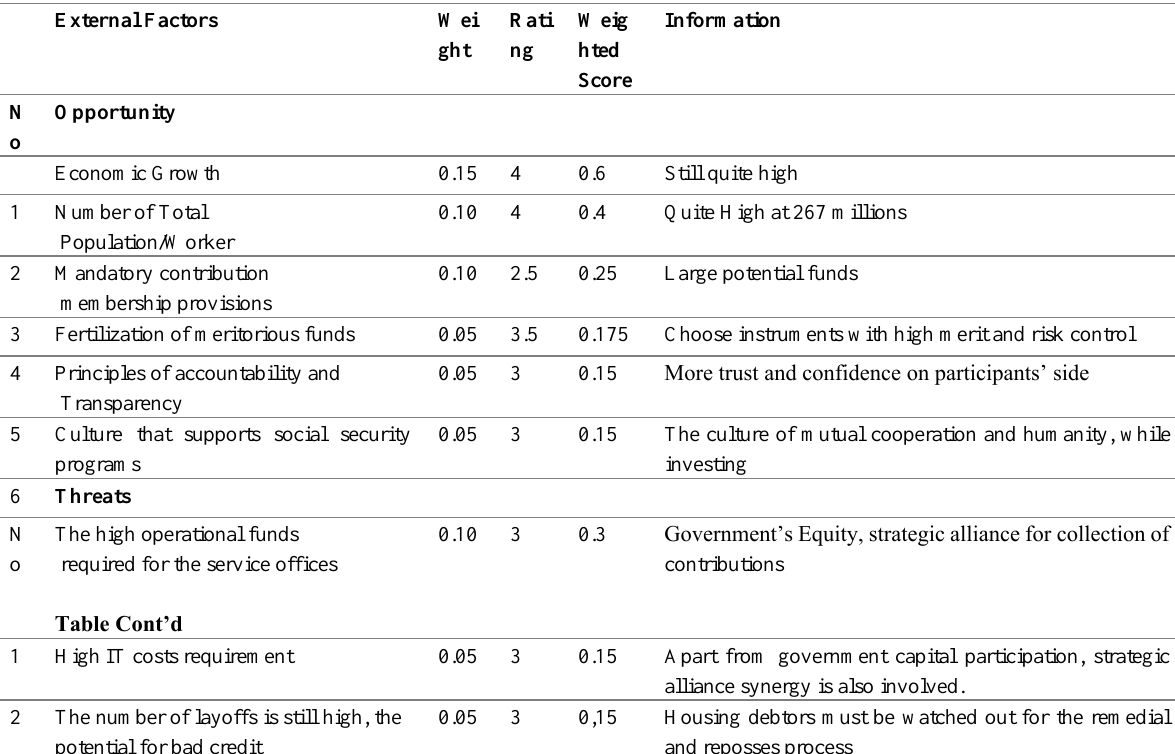
Table 3: EFAS of Program